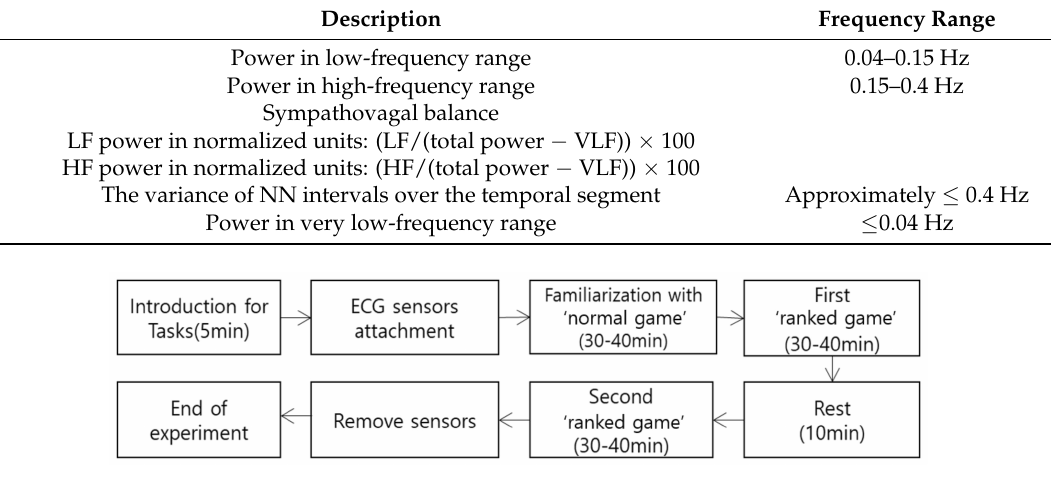
Table 2. Frequency-domain variables of heart rate variability [38].